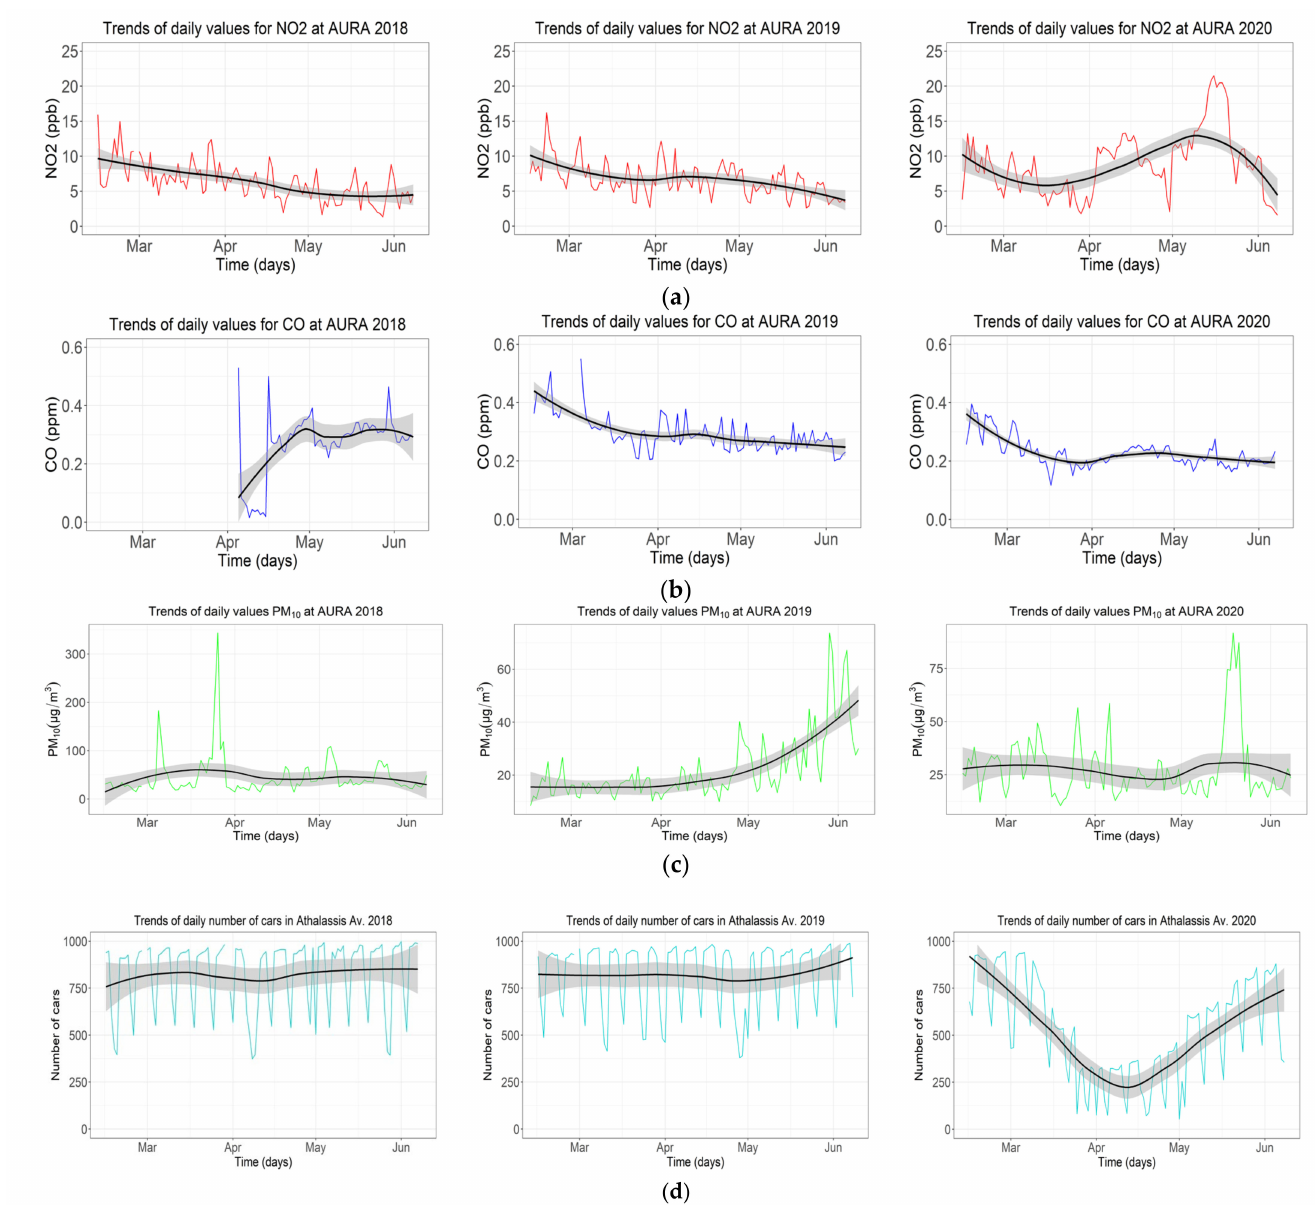
Figure 4. The average daily variation of the three pollutants concentrations in coloured lines for ( a ) NO 2 , ( b ) CO, ( c ) PM 10, at the AURA station, as well as ( d ) the daily variation of car number in Athalassis Avenue in 2018, 2019 and 2020. (Black line denotes the trend line of the daily average (using the LOESS method), and the grey shaded area denotes their corresponding standard